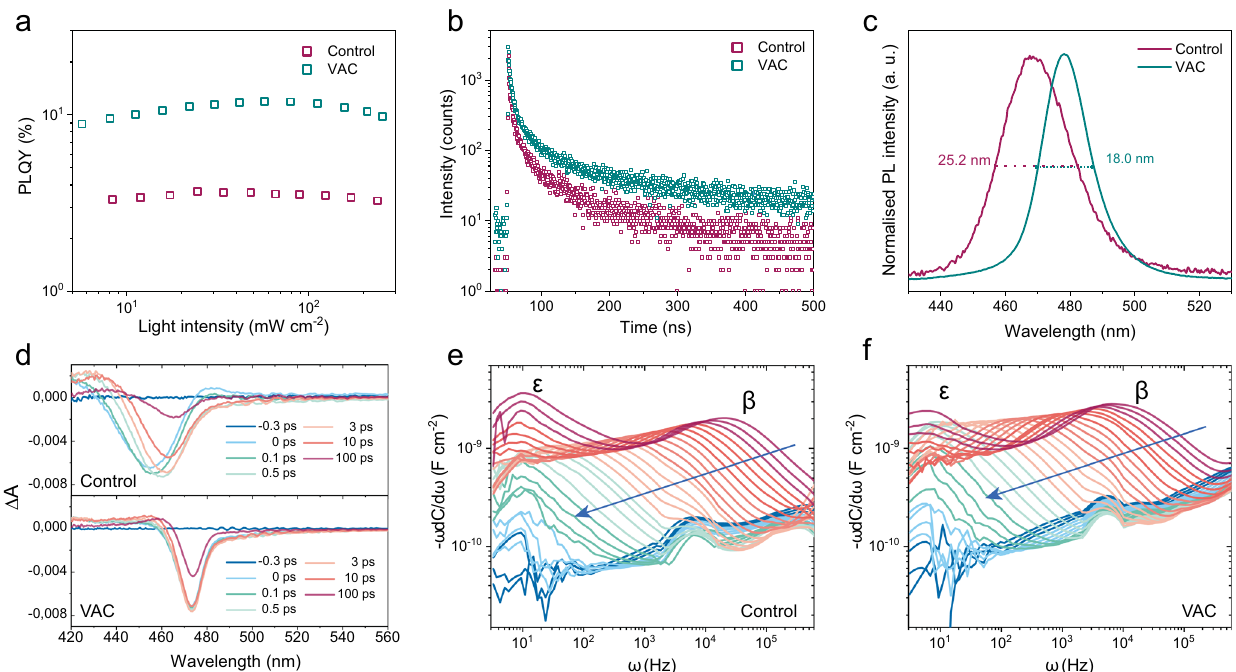
Fig. 2 Understanding superior spectral stability of VAC-treated devices. a – d Photophysical characterizations for control and VAC-treated perovskite fi lms: Fluence-dependent PLQYs ( a ); PL decay measured by TCSPC ( b ). PL spectra ( c) ; Transient absorption of control (top) and VAC-treated fi lms (bottom) after excitation at 400 nm ( d ). e , f Derivatives of temperature-dependent capacitance versus frequency plots for control ( e ) and VAC-treated ( f ) devices. The blue arrows indicate temperature change from 350 K to 200 K. Here, two mobile ions marked as β and ε are